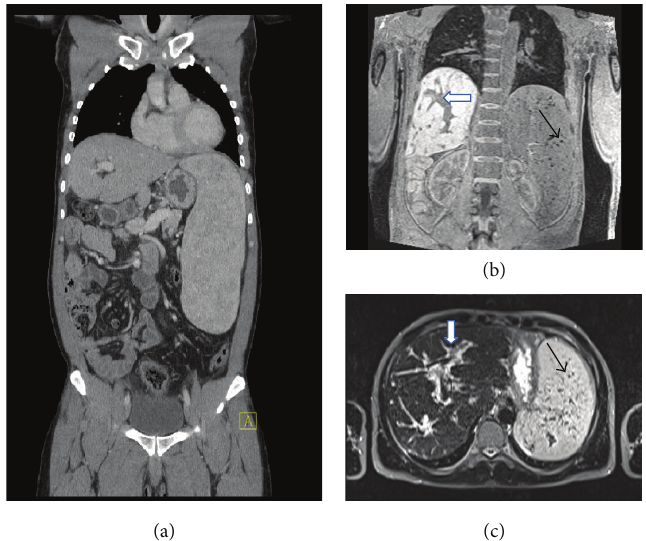
Figure 1: (a) Computerized tomography (CT) imaging showing the enlarged spleen (b) and (c) magnetic resonance imaging (MRI) demonstrating the periportal fibrosis (white arrows) and the Gamna-Gandy bodies (siderotic nodules) in the spleen (black